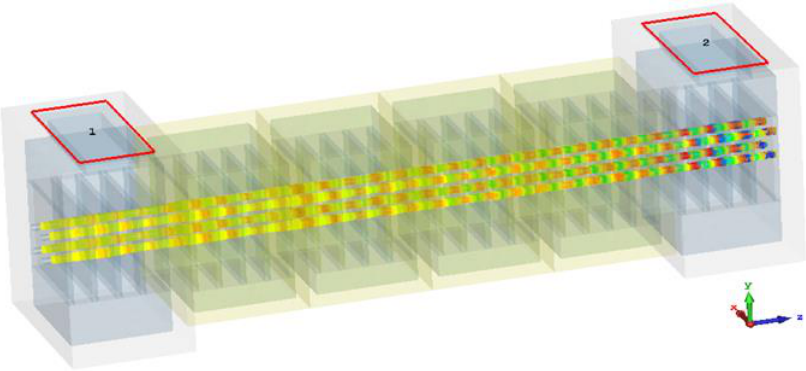
Figure 13. Beam – wave interaction of Ka-band ladder-type multibeam EIK.